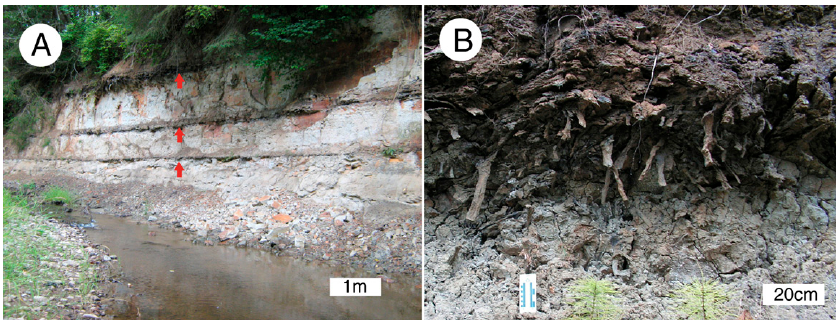
Figure 14. Distal lacustrine lahar deposits in the Miocene Wilkes formation in southeast Washington, USA [34 ] . ( A ) Streambank exposure reveals three successive wood mats (arrows). ( B ) These lahar deposits contain rough-surfaced fragments of mummified wood in a wide range of sizes. Each wood mat is preserved at the top of a fining-upward cycle.